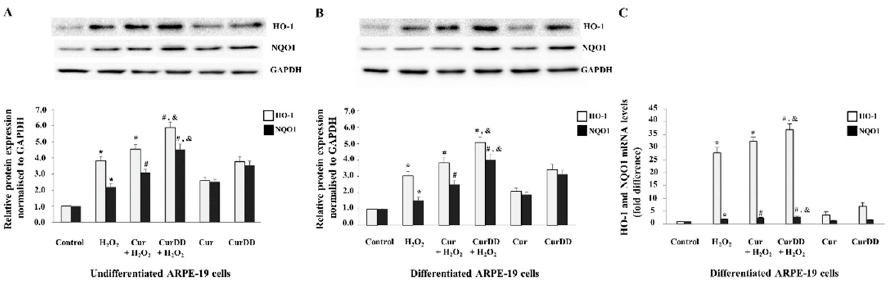
Figure 7. Protective effects of Cur and CurDD against oxidative stress occurs through modulation of antioxidant enzymes HO-1 and NQO1. ARPE-19 cells were pre-treated with 10 µM of Cur or CurDD for 24 hours, followed by H 2 O 2 treatment at appropriate concentrations (400 and 200 µM for undifferentiated and differentiate cells, respectively) for 6 hours. Protein levels of HO-1 and NQO1 were assessed by immunoblotting in ( A ) undifferentiated and ( B ) differentiated ARPE-19 cells. GAPDH immunodetection was used as a loading control. Representative Western blots shown, with graphs presenting average normalised protein expression; ( C ) mRNA levels of HO-1 and NQO1 were analysed by qPCR in differentiated ARPE-19 cells. Graph represents average expression normalised against four housekeeping genes as described in Methods. (For both protein and mRNA, data is presented as mean ± SD values, n = 4; One-Way ANOVA test,* p ≤ 0.05 vs. control group,* p ≤ 0.05 vs. control group, # p ≤ 0.05 vs. H 2 O 2 group, and & p ≤ 0.05 vs. Cur + H 2 O 2 group).